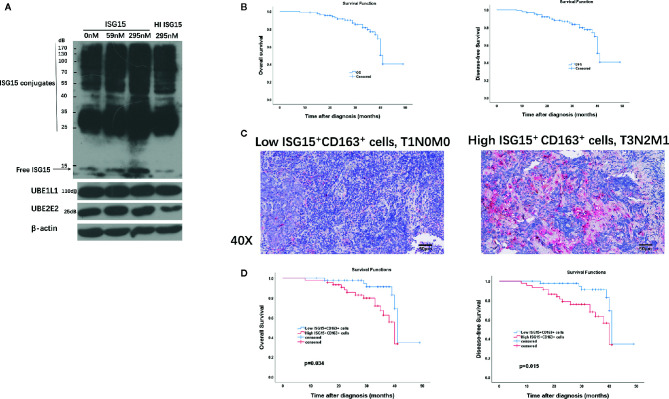
Clinical implication of tumor-associated macrophages (TAMs) and ISG15-expressing TAMs in NPC. (A) Intracellular free and conjugated ISG15, and ISGytion E1 enzyme (UBE1L) and E2 enzymes (UBE2E2) were assessed by Western blotting on total cell lysates of rISG15 treated macrophages. (B) Kaplan-Meier survival curve of overall survival (OS) and disease-free survival (DFS) in the TMA contained 90 NPC biopsy specimens. (C) Representative immunohistochemistry data with double staining of CD163 (in wine red) and ISG15 (in brown) in early (T1N0M0) and advanced (T3N2M1) Tumor Node Metastasis (TNM) stage in NPC samples. Scale bars, 50 μm. (D) Kaplan-Meier survival curve of OS and DFS in NPC patients with distinct ISG15+ CD163+ TAMs count.